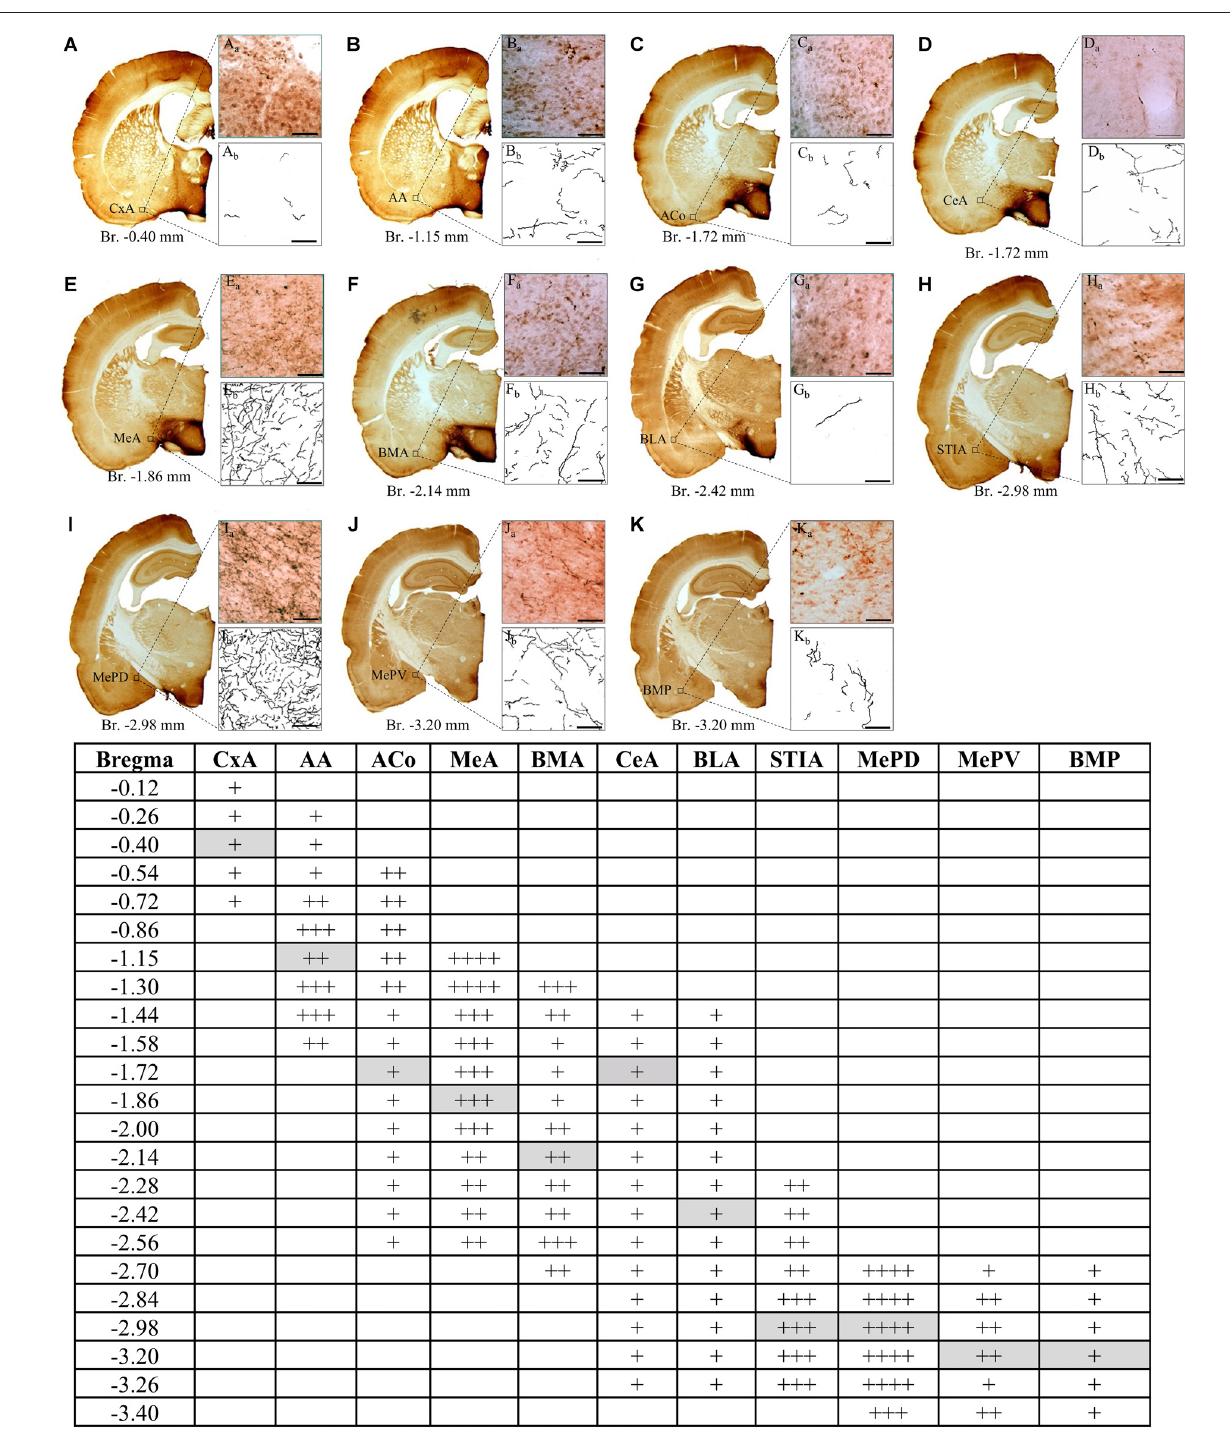
FIGURE 1 | Distribution of vasopressin-immunostained fibers through the rostrocaudal extent of amygdala in the rat. Low (A–K) and high power (A a –K a ) photomicrographs and tracings of arginine-vasopressin (AVP) labeled fibers (A b –K b ) in coronal sections, illustrating the heterogeneous distribution in the density of AVP fibers among different amygdalar regions. The highest density was found in the MePD region at Bregma level − 2.70 mm (panel I , and table). Each of the panels from (A–K) corresponds to a representative example at the bregma level indicated in the table gray boxes. For the semiquantitative analysis in the table, the summed length (calculated with ImageJ) of fibers in a 0.04 mm 2 area, inside this highest density region was assigned as 100%, regions with summed lengths between 76–100% were assigned as ++++; between 51–75% : +++; between 26–50%: ++ and between 1–25%: